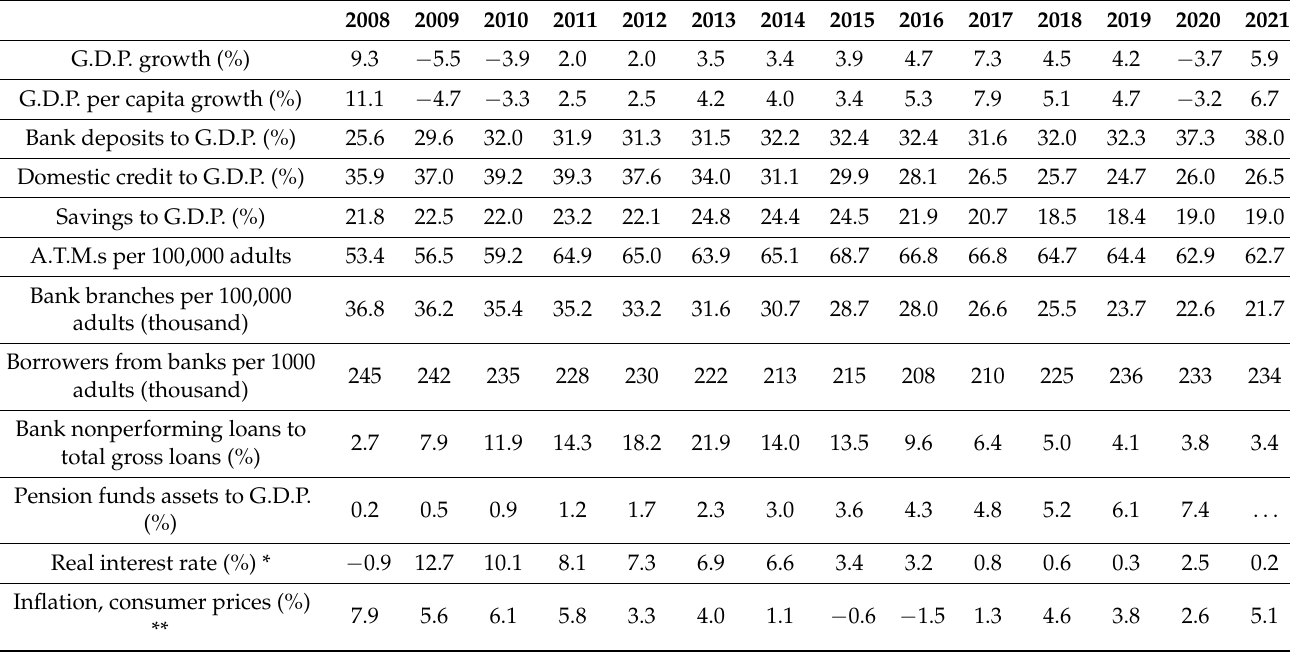
Table 1. Key Financial Statistics, Romania,